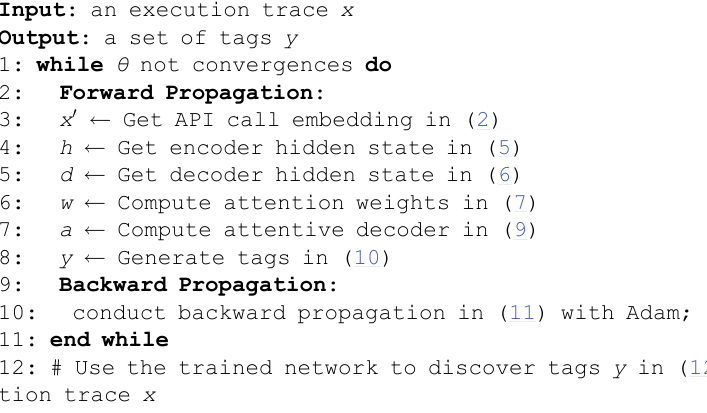
Algorithm 1 concludes the operations of TagSeq neural network model described above. Algorithm 1 TagSeq Neural